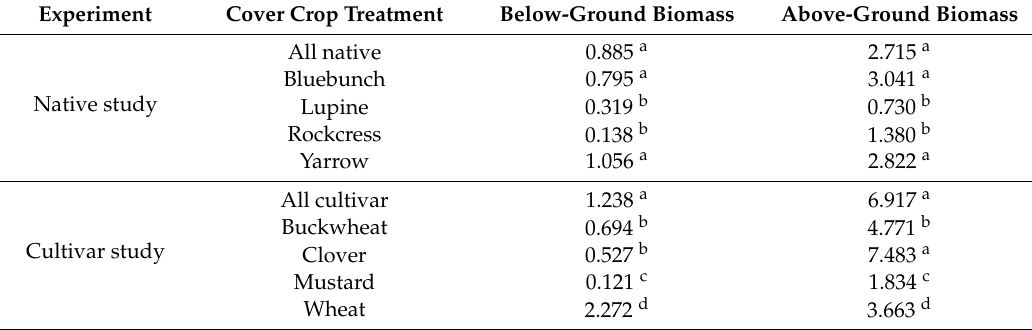
Table A4. Average biomass (grams) for each cover crop treatment in native and cultivar studies. Cover crops are bluebunch wheatgrass (“bluebunch”), silky lupine (“lupine”), Holboell’s rockcress (“rockcress”), white yarrow (“yarrow”), buckwheat (“buckwheat”), crimson clover (“clover”), white mustard (“mustard”), and wheatgrass (“wheat”). Letters to the right of values indicate significance at p ≤